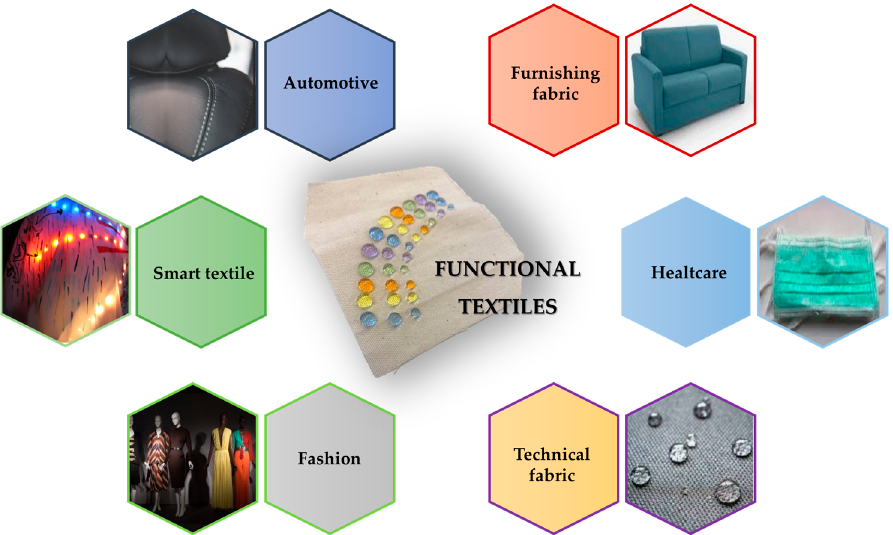
Figure 12. Some application fields of functional and coted textile fabrics. Reproduced from MDPI Ref. [67].